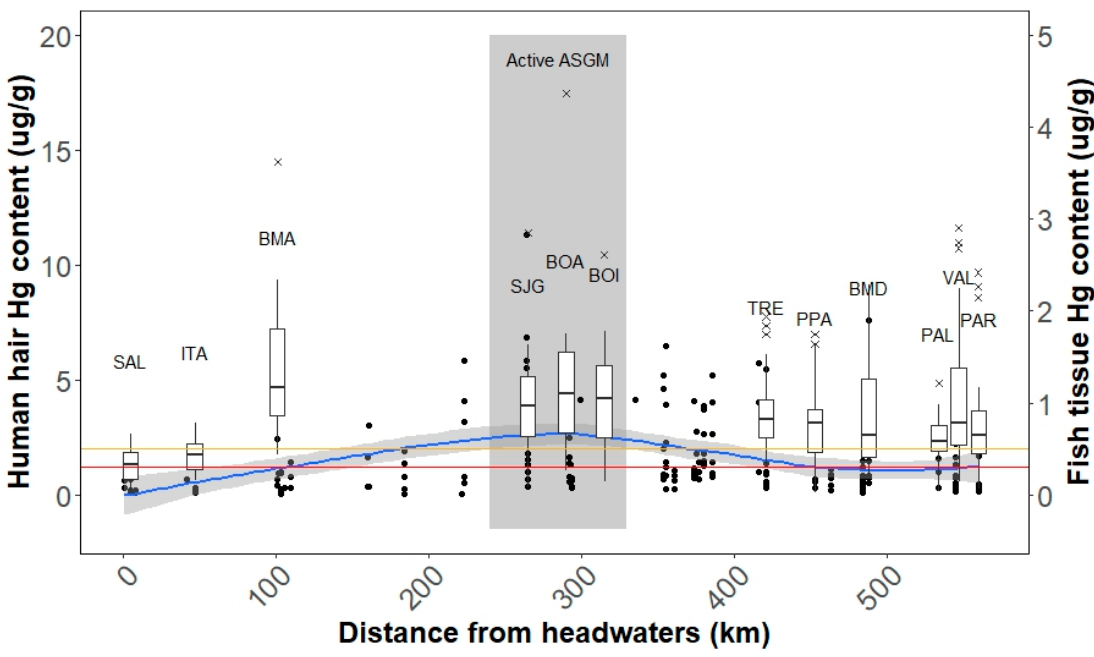
Figure 2. Total mercury content (µg/g) of human hair (left y-axis) and wet weight fish muscle (right y-axis) by location from headwaters along the Madre de Dios River. Boxplots indicate the variation in hair mercury and hair outliers are indicated by “x” symbols. Mercury content in fish tissue was reported previously and is indicated with black circles [46]. A LOESS (locally weighted smoothing) curve (blue line with grey 95% confidence intervals) was added to visualize the relationship between fish tissue mercury for all trophic levels and location along the river. Hair mercury limits for the USEPA (1.2 µg/g, red line) and WHO (2.0 µg/g, yellow line) are also indicated. The grey region indicates communities where intensive active mining is present (240–330 km).